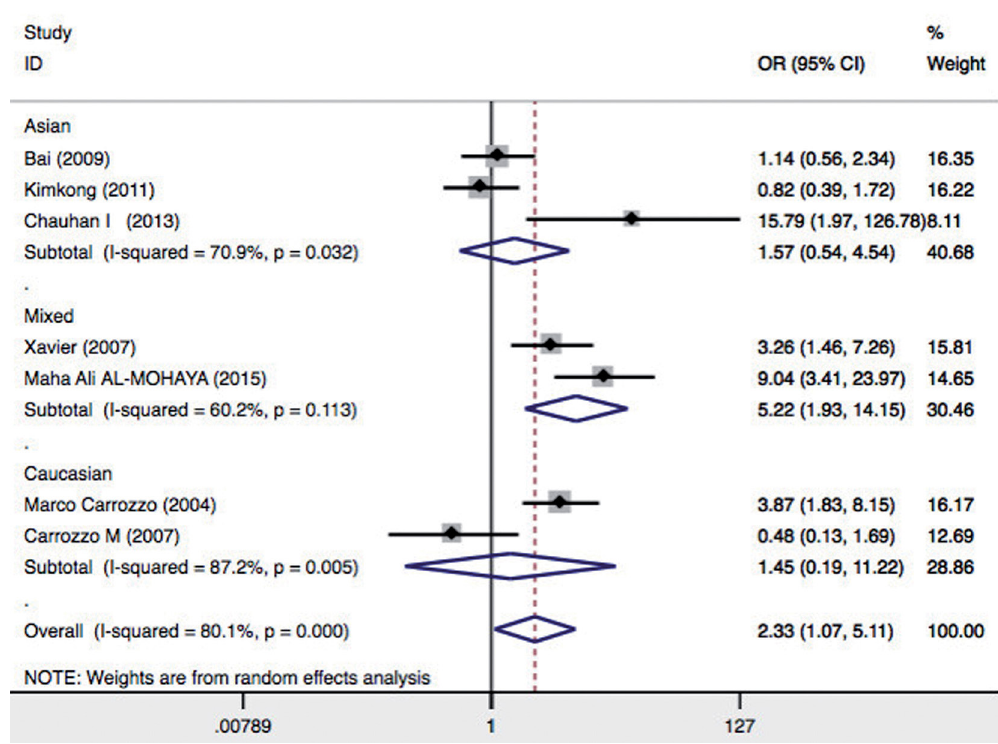
Figure 3- Forest plot of oral lichen planus (OLP) risk associated with TNF- α -308 G/A stratified by ethnicity. For each study, the estimate of OR and its 95%CI is plotted with a box and a horizontal